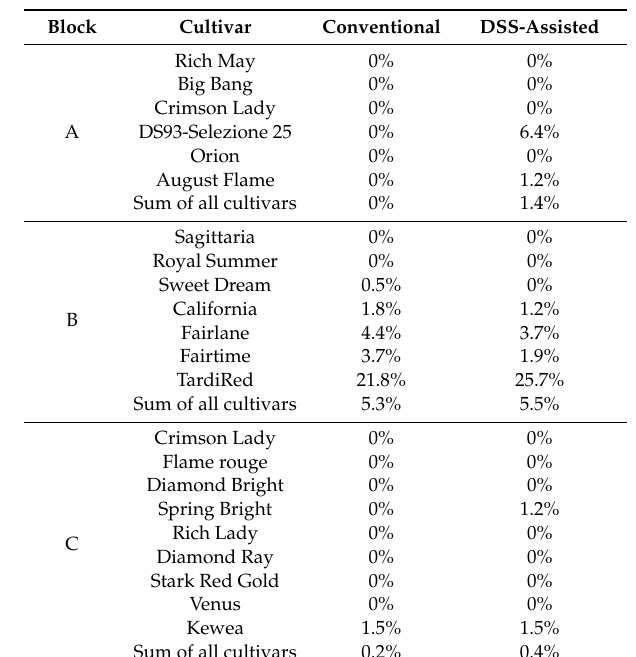
Table 1. Percentages of damaged fruits sampled in the conventional plots and DSS-assisted plots, calculated for each block and each